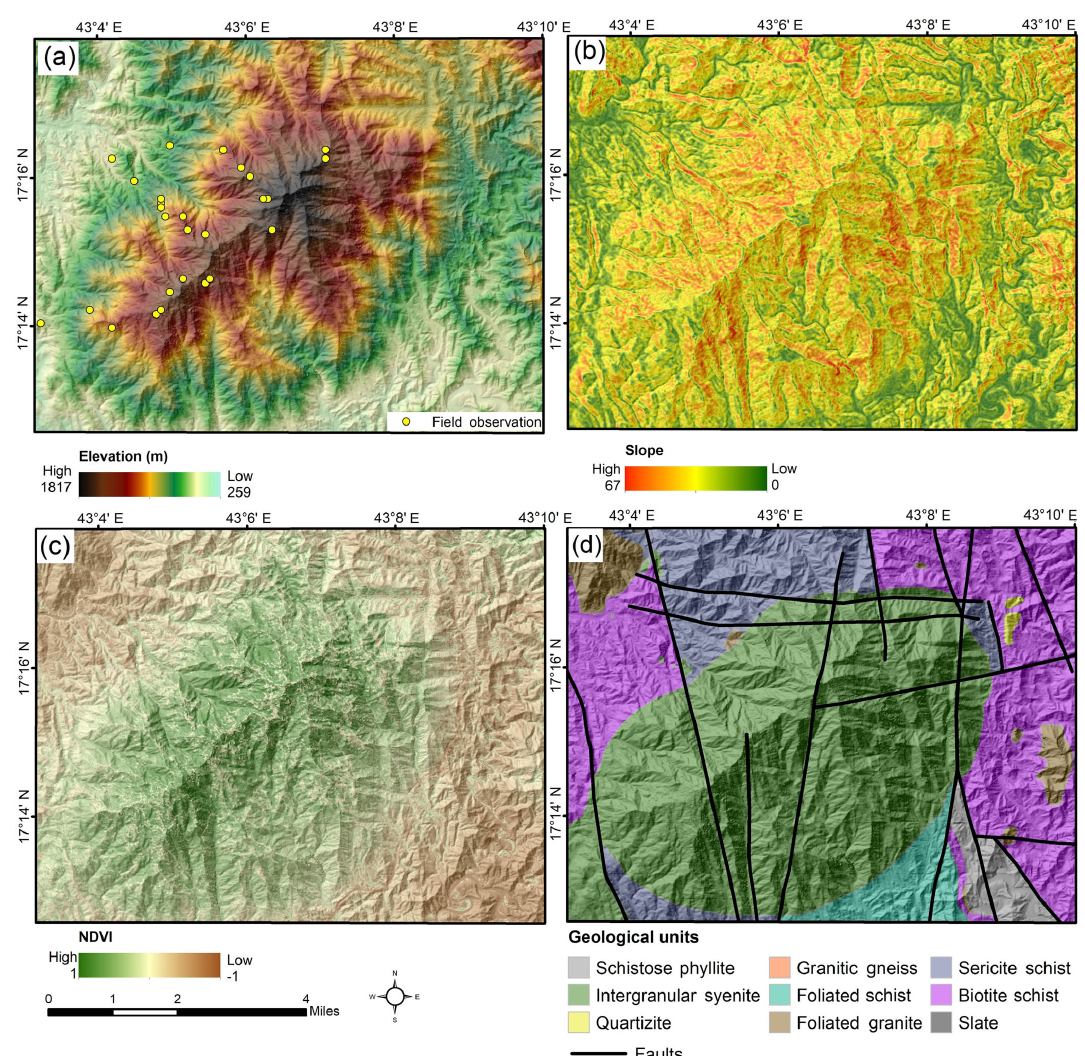
Figure 2. Maps showing the study area. (a) Elevation map showing locations where field observations were collected for the period extending from 26 February to 7 March 2016. (b) Slope map generated from TanDEM-X DEM. (c) NDVI map generated from Sentinel-2 data (date of acquisition: 5 June 2017). (d) Geologic map for the Faifa Mountains (after Fairer, 1985, and Alharbi et al.,